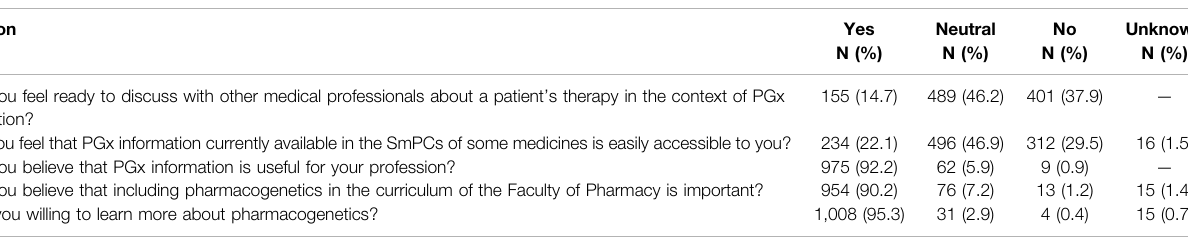
TABLE 4 | Pharmacists ’ attitude toward